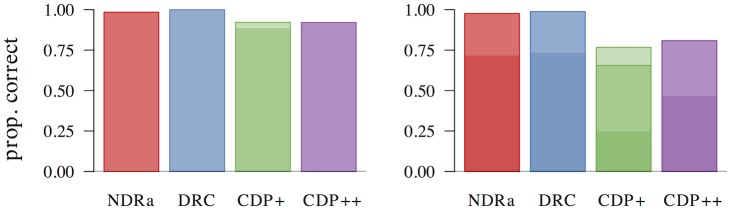
Pronunciation performance: Non-words.Non-word pronunciation performance for the nonwords from the ARC non-word database (left panel) and for the Pritchard et al. (2012) data (right panel). Lighter shaded green areas in both panels indicate additional pronunciation accuracy in the cdp+ model when the naming activation criterion parameter is changed from 0.67 to 0.50.